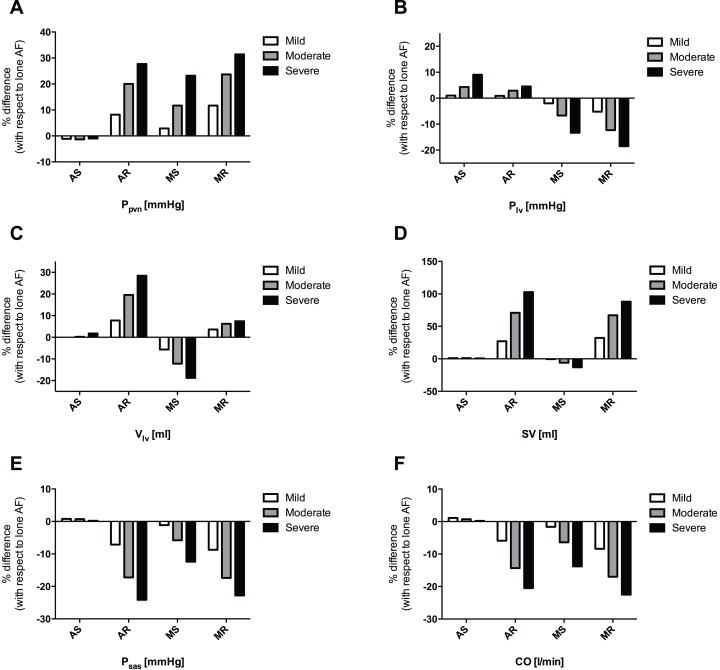
Grouped plot displaying percentage variations, referred to lone AF simulation, of selected computed variables for each concomitant valvular disease.(A) Ppvn, (B) Plv, (C) Vlv, (D) SV, (E) Psas, (F) CO.